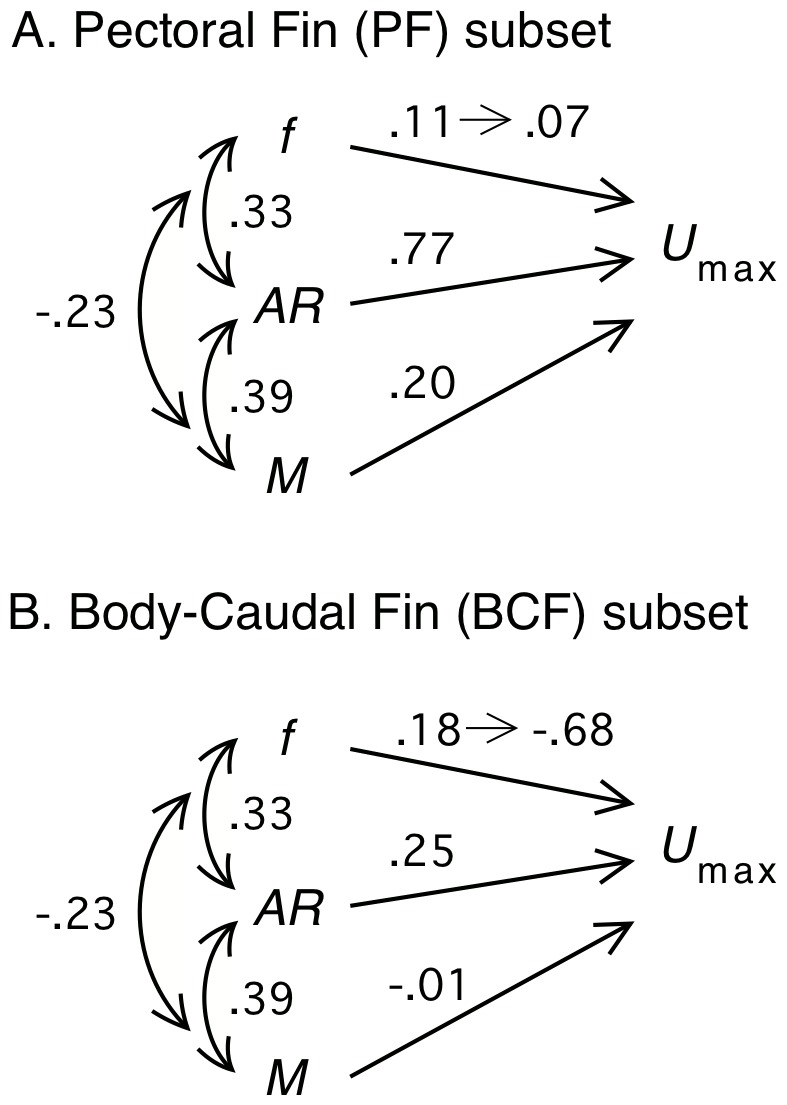
Path model of effect of predictor variables on maximum prolonged-swimming speed (logU
max).(A) pectoral fin (MPF) and (B) body and caudal fin (BCF) subset of coral reef fish species. Predictor variables are f (body fineness ratio), f
2, AR (propulsive fin aspect-ratio), and logM (body mass). The linear and quadratic effects of f are combined to give the range of the effect from the f
min to f
max. The β coefficient (the number above the directed path) for each predictor is the model-averaged (standard partial regression) coefficients as described in the text. Correlations among predictors are given next to the bi-directional path.